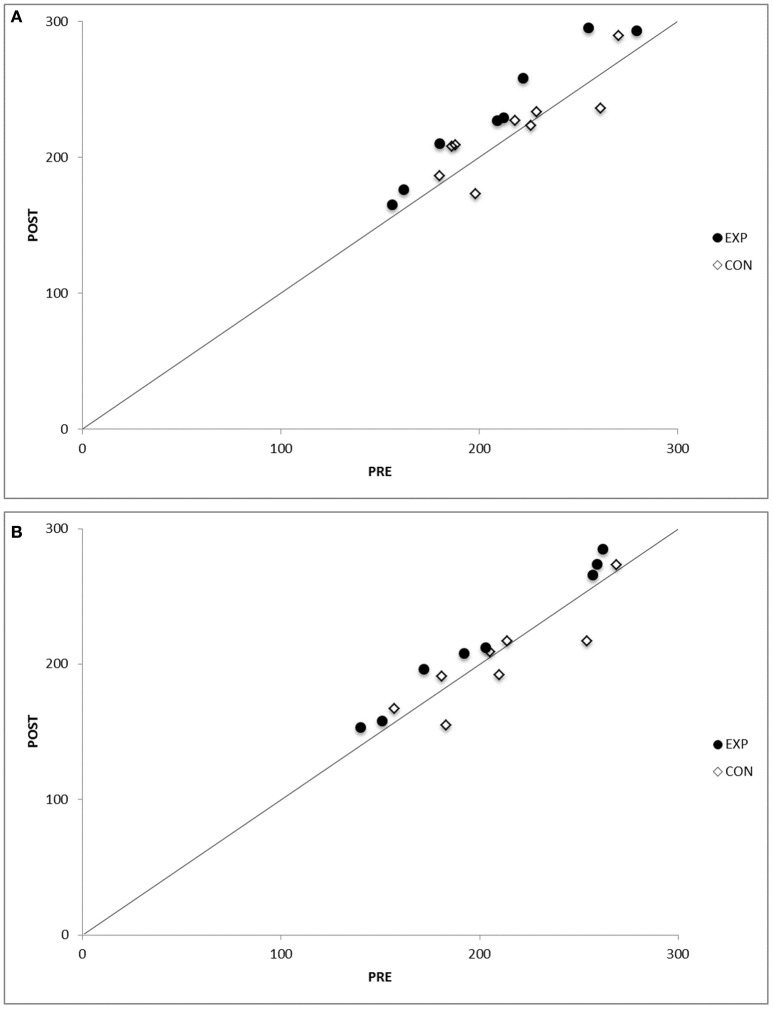
(A) Test–retest reproducibility in the control/experimental group subjects during the time trial test (TT) test, before (Pre), and after (Post) the intervention period in normoxia. Identity lines are drawn in both graphs. See text for numerical analysis. (B) Test–retest reproducibility in the control/experimental group subjects during the time trial test (TT) test, before (Pre), and after (Post) the intervention period in hypoxia. Identity lines are drawn in both graphs. See text for numerical analysis.